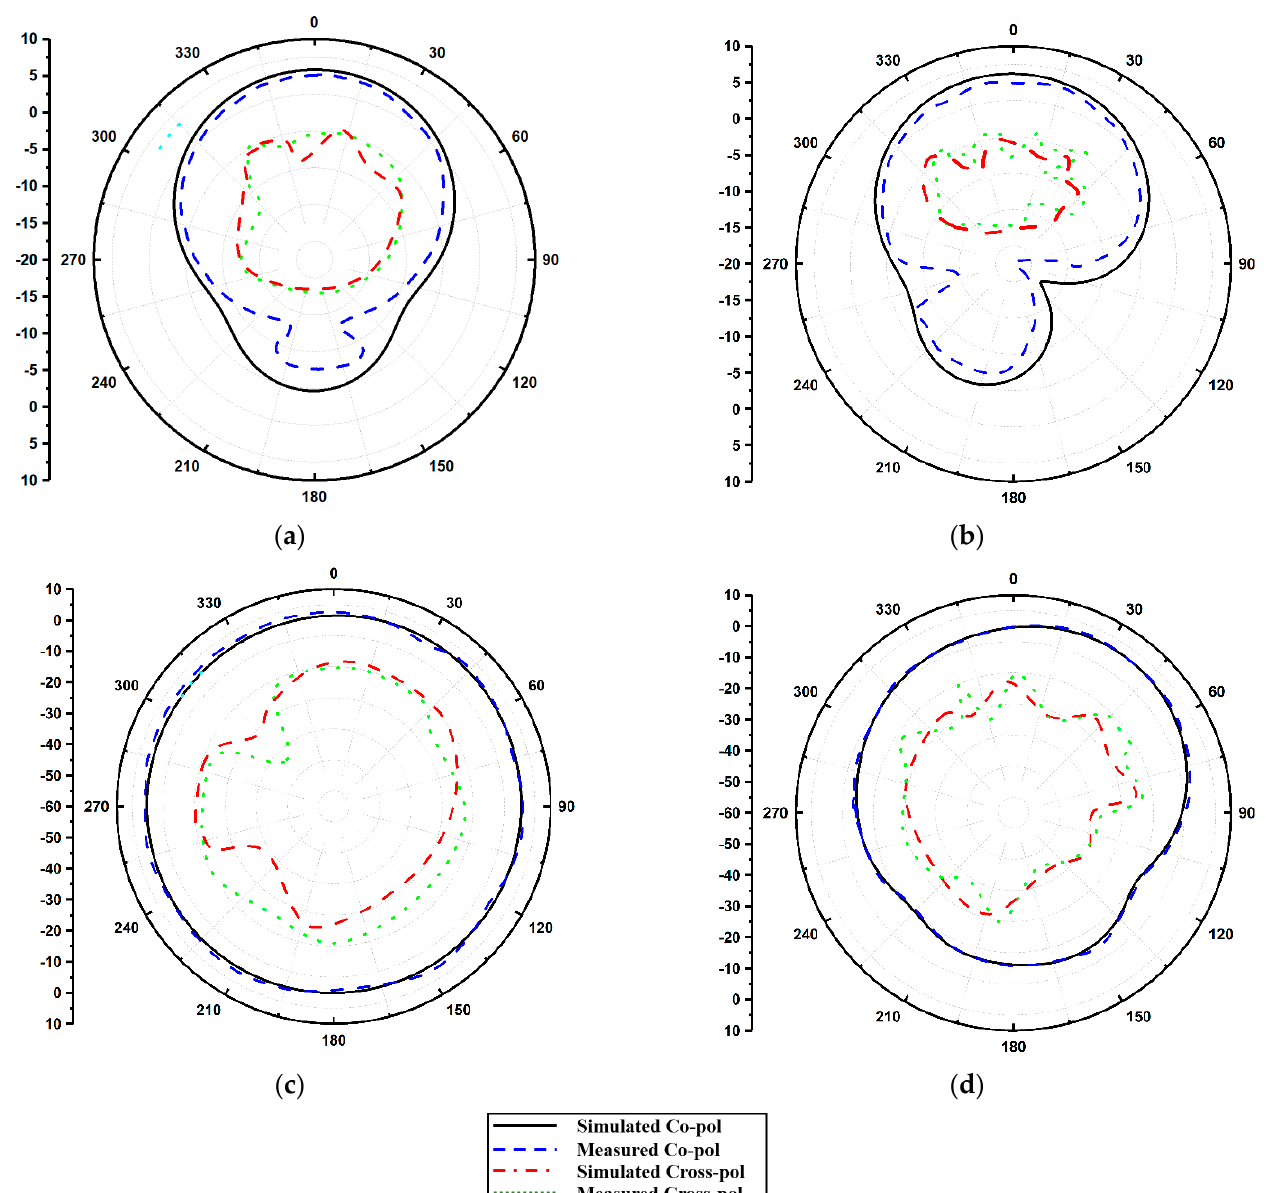
Figure 8. Antenna radiation pattern: ( a ) E-Plane 3.3 GHz, ( b ) E-Plane 3.9 GHz, ( c ) H-Plane 3.3 GHz, and ( d ) 3.9 GHz.